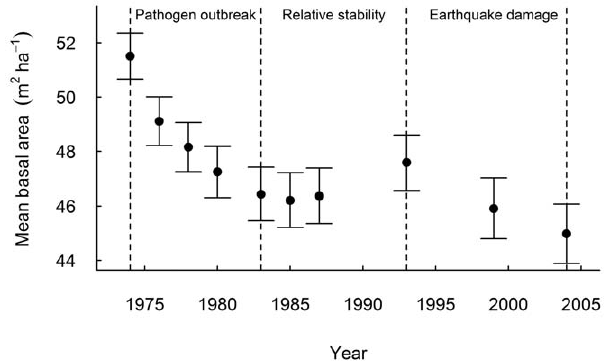
Figure 1. Basal area trend over the study period. Mean ( 6 SEM) tree basal area (m 2 ha 2 1 ) for study-area mountain beech forest from permanent plot measurements between 1970 and 2004. Dashed lines indicate the plot measurements used in this study to construct individual-based mortality models.